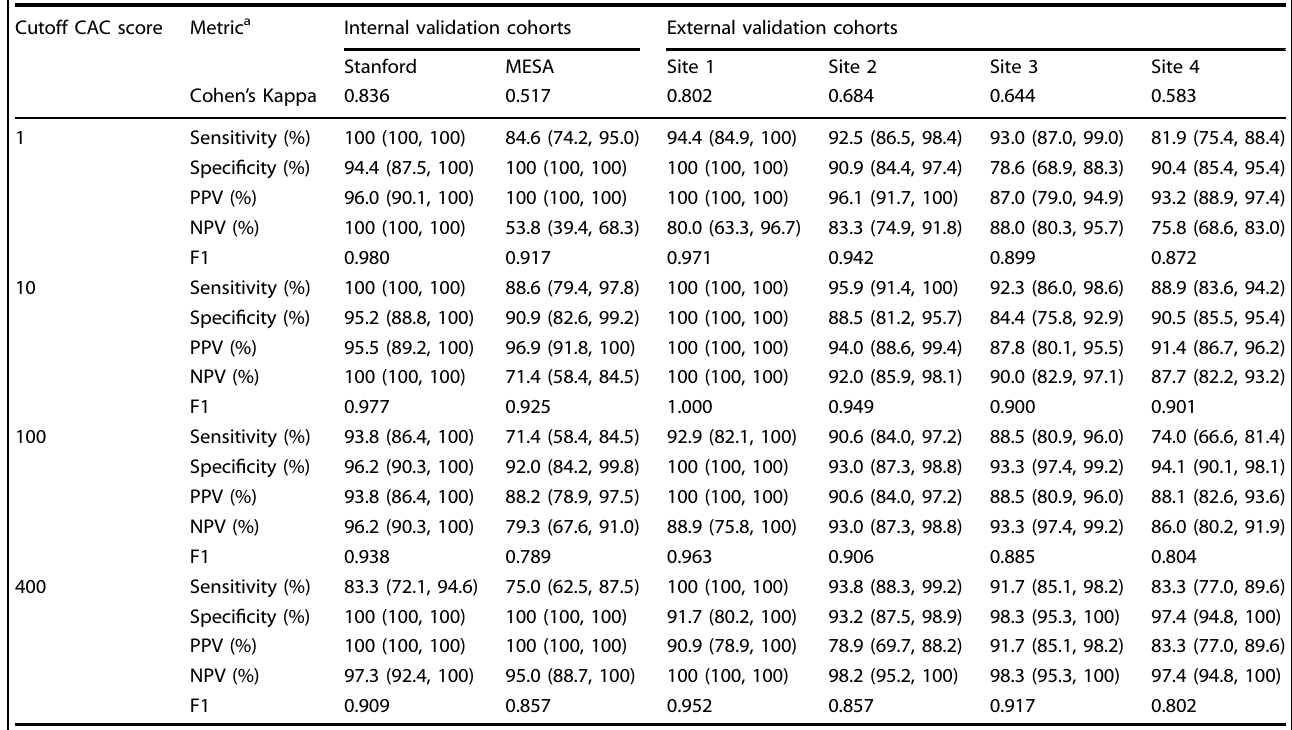
Table 3. Diagnostic performance of non-gated model.